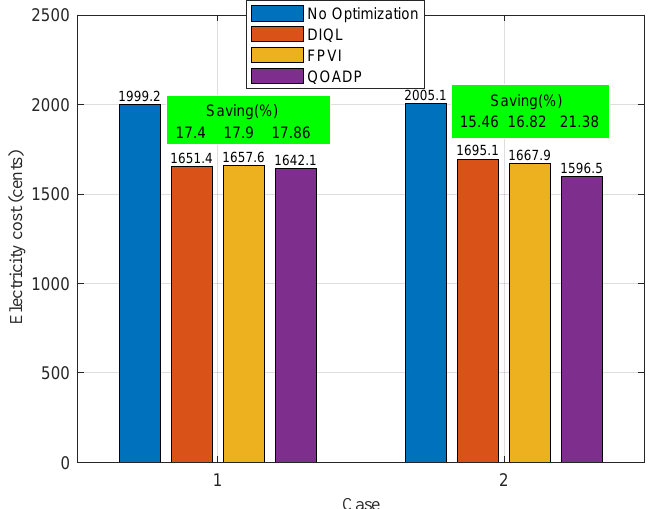
Figure 9. Electricity costs of three